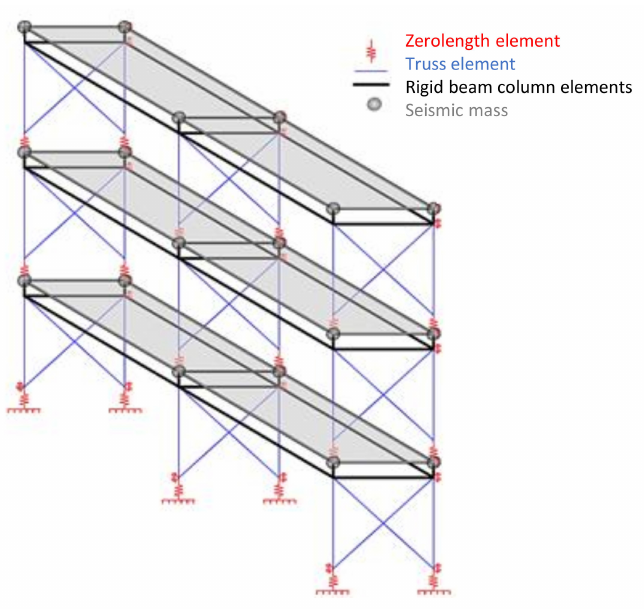
Figure 6. Schematic drawing of models developed.